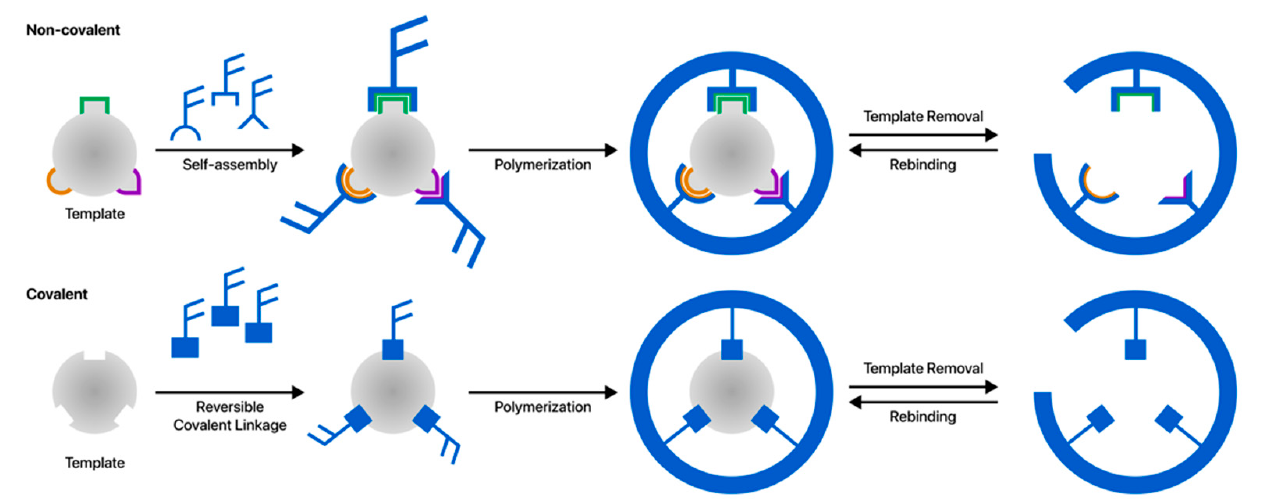
Figure 1. MIP procedures: non-covalent and covalent imprinting. (Adapted from [29]).